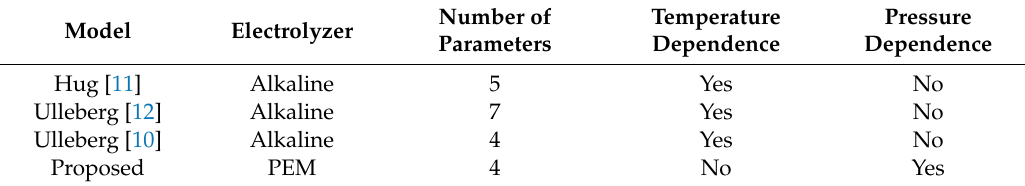
Table 5. Comparison between the previously reported models and proposed model. Model